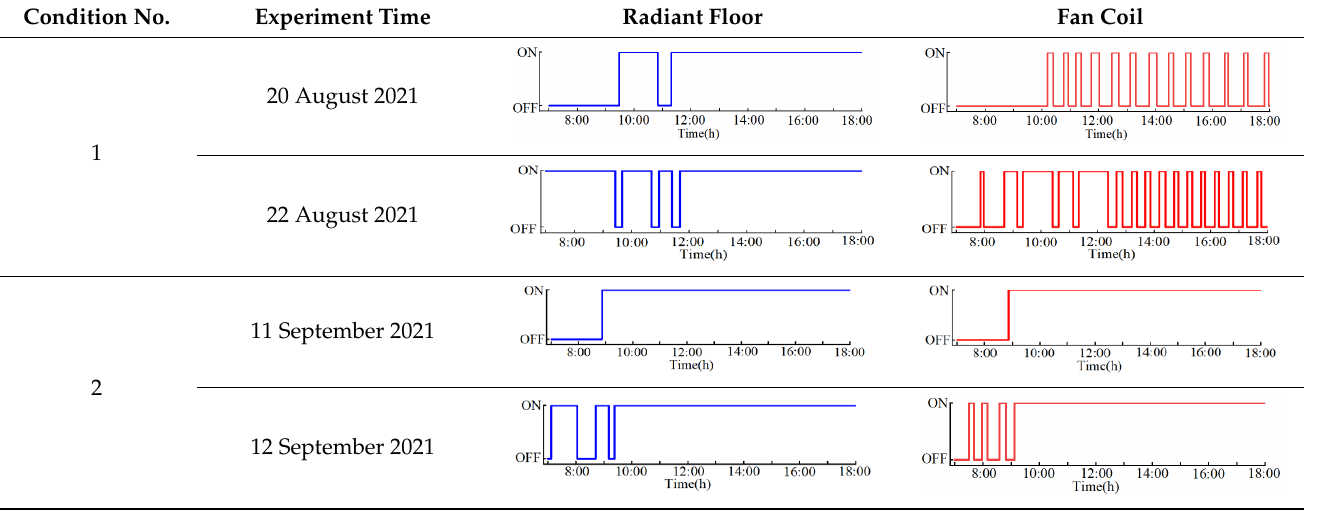
Table 5. Outdoor weather conditions classification table.